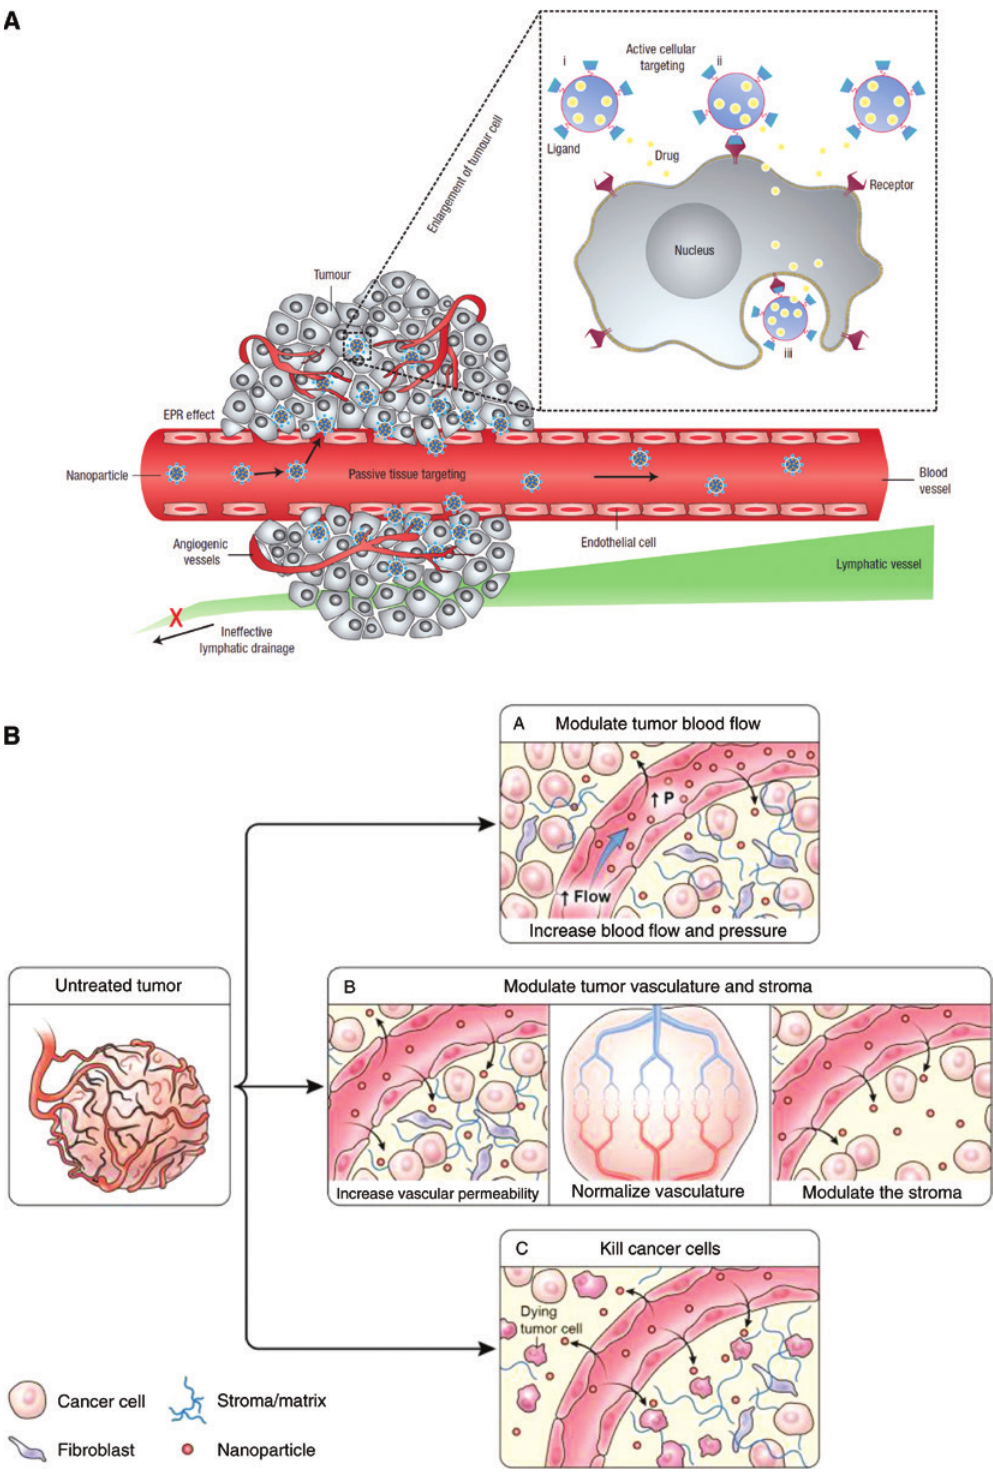
Figure 1: How to improve nano-delivery into tumor beds beyond intrinsic EPR effects. (A) Schematic view of nanodrug delivery. Passive targeting is achieved by the leakage of nanodrugs due to increased vascular permeability and retention due to poor venous and lymphatic drainage (EPR effect). Active targeting (inset) is accomplished by functionalizing the nanodrug surface, leading to increased binding of the nanodrug to target cells. Reprinted by permission from Springer Nature: Peer D et al. “Nanocarriers as an emerging platform for cancer therapy” Nature Nanotechnology. Copyright 2007. (B) Strategies for improving the EPR effects by modifying intrinsic physiological conditions: (1) modulation of tumor blood flow using vasoconstrictor or vasodilator, (2) modulation of tumor vasculature and stroma, and (3) elimination of tumor cells. Adapted from Ref.